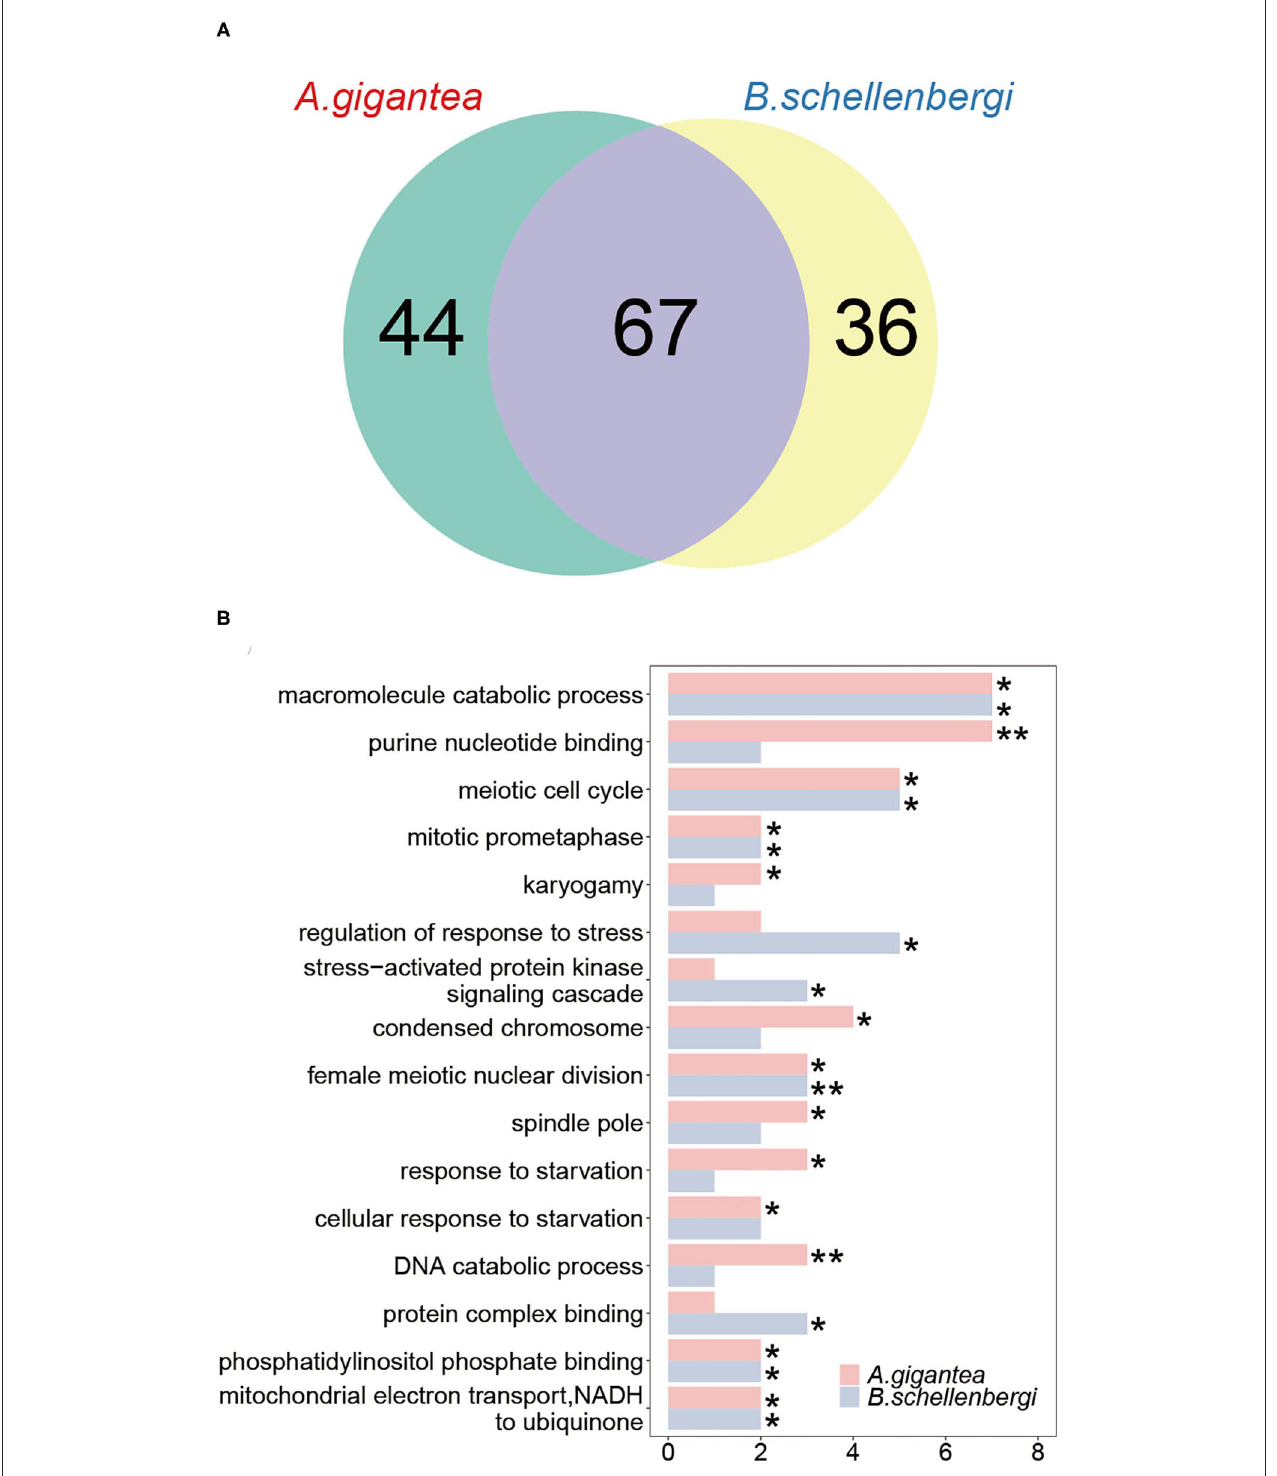
FIGURE 4 | Gene ontology (GO) enrichment analysis of the positively selected genes (PSGs) in A. gigantea and B. schellenbergi. (A) The Venn diagram shows the numbers of the PSGs in A. gigantea and B. schellenbergi. The two hadal species have more shared PSGs (67) than they solely owned PSGs (44 for A. gigantea and 36 for B. schellenbergi ). (B) GO enrichment results of PSGs in A. gigantea and B. schellenbergi. The abscissa indicates the number of annotated genes that were assigned to GO terms. These enriched genes were mainly related to “starvation response” and “meiosis.” Statistically significant enrichment results are indicated by asterisks (*indicates the value of p < 0.05, **indicates the value of p < 0.01).